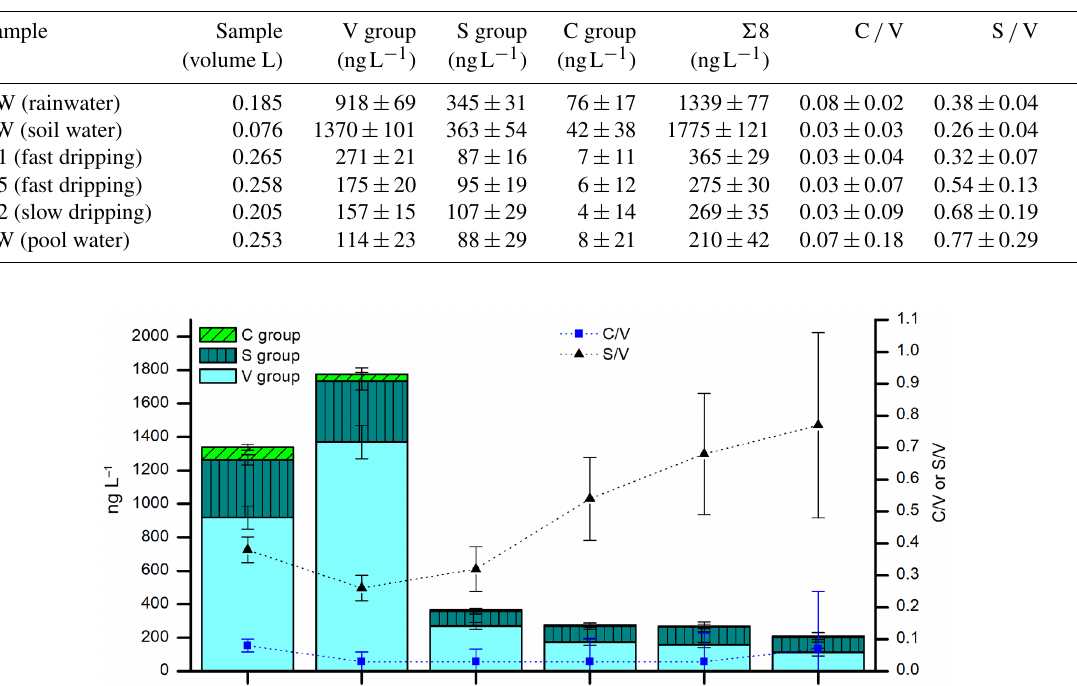
Table 5. Concentrations of the V-, S-, and C-group LOPs, the sum of all eight LOPs ( (cid:54) 8), and the ratios C / V and S / V in different water samples collected at the Herbstlabyrinth-Advent Cave in October 2014.